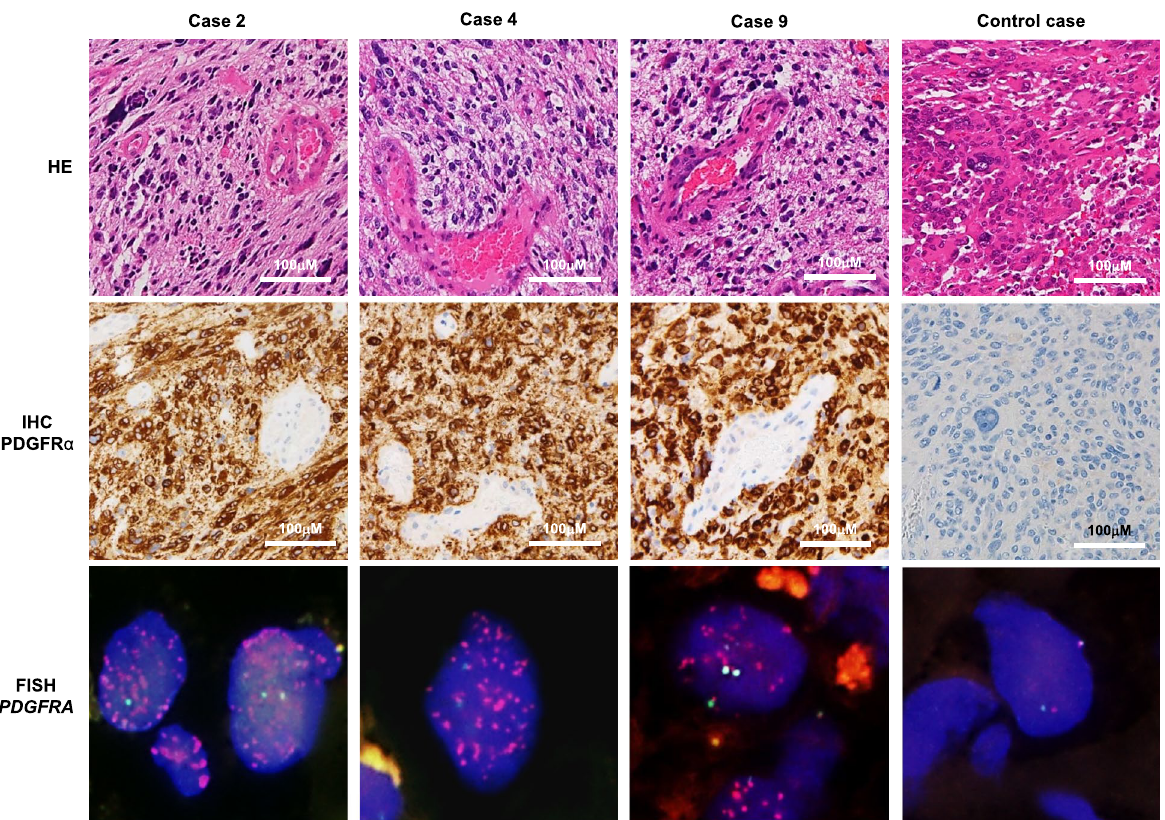
Figure 1. Representative histology, immunohistochemistry (IHC), and fluorescence in situ hybridization (FISH) of GBM cases with the PDGFRA c.1403A > G mutation. Representative histology, PDGFRα immunohistochemistry, and PDGFRA FISH images of GBM cases are shown. The H&E sections demonstrate a typical GBM morphology consisting of a dense proliferation of highly atypical tumor cells with high vascularity and palisading necrosis. PDGFRα was diffusely positive in the cytoplasm and FISH showed the amplification of the PDGFRA gene (green, centromere; red, PDGFRA gene) in PDGFRA -mutated cells but not in wild-type cells. The control case is a GBM without PDGFRA amplification and